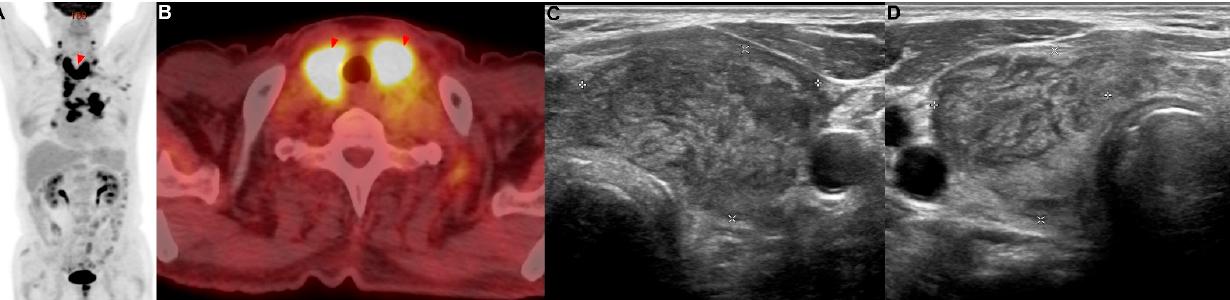
Figure 2. Patient 2: a 77-year-old man diagnosed with squamous cell carcinoma of the lung with metastases in the thyroid. ( A , B ) PET/CT showed metastatic lesions (red arrowhead) in the bilateral lobes of the thyroid. ( C , D ) Metastatic lesions were observed in the ( C ) left and ( D ) right thyroid.